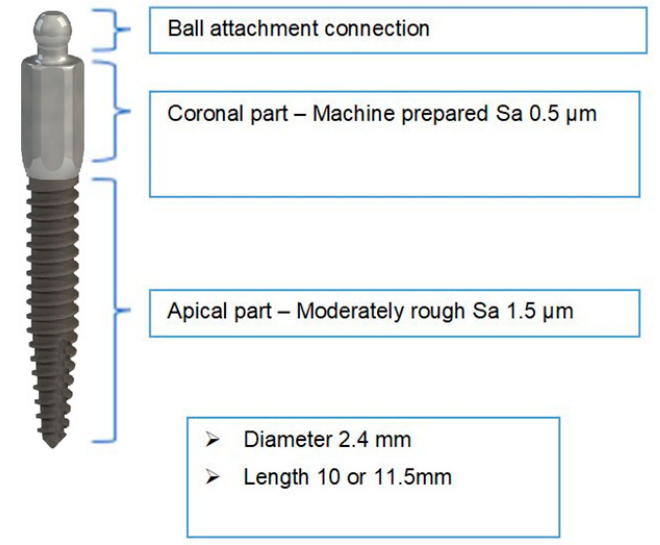
Figure 1. ILZ prototype mini ‐ implant Southern Impl., Inc., Irene, South Africa.